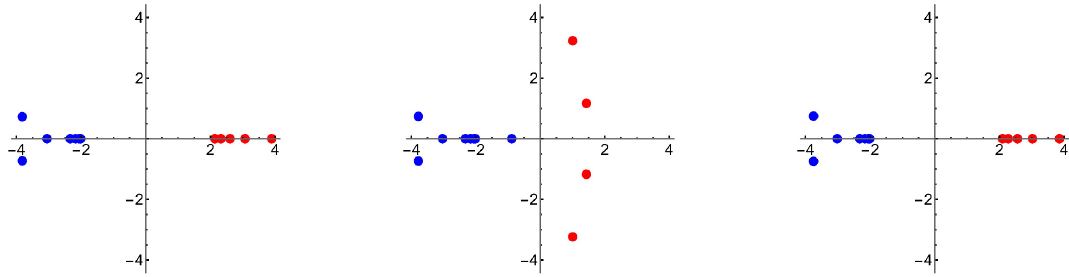
Figure 1. Left to right, for κ = 0 . 98 , 1 and 1 . 02 , the Borel-Padé-poles in the ζ -plane. Evident are singularities at ζ = ± 2 , with the positive pole removed for κ = 1